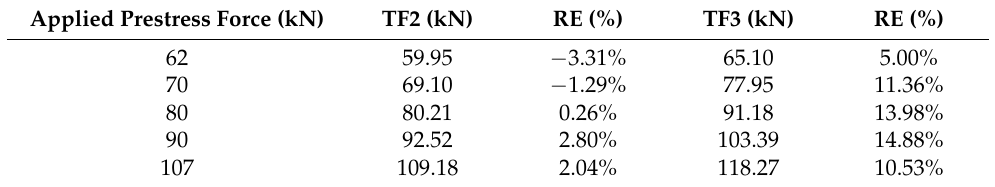
Table 11. Comparison between the applied and predicted prestress forces from the proposed approach. Applied Prestress Force